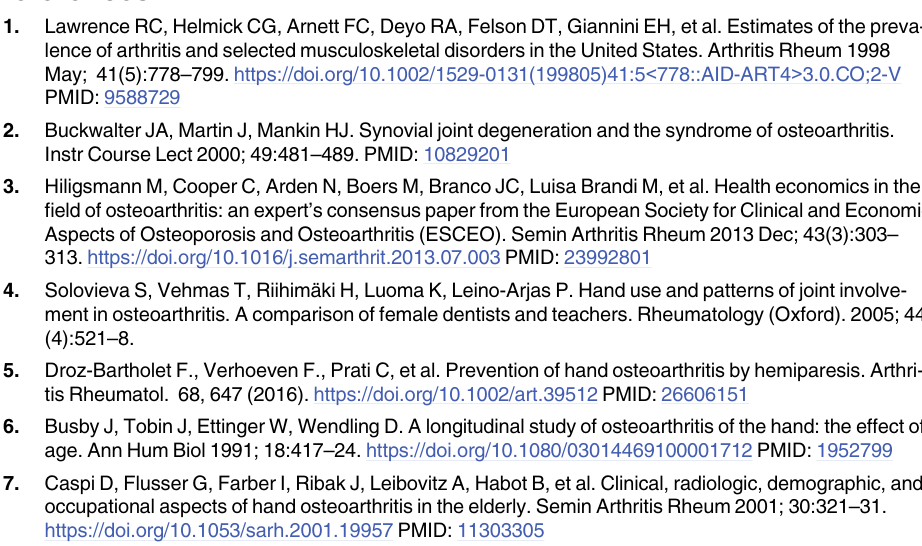
S1 Fig. Flowchart of participants for analysis. Abbreviations: MRI, magnetic resonance imaging; N, number of patients; OA, osteoarthritis; RCT, rotator cuff tear (JPG) S1 Table. Factors associated with the prevalence of rotator cuff tear in all participants: the association between rotator cuff tear and hand